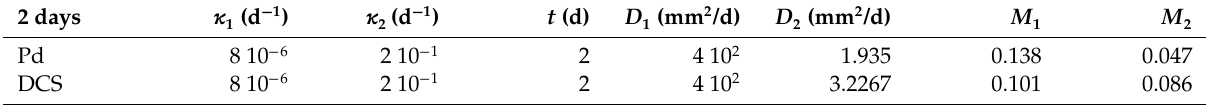
Table 5: Parameter values for chloride concentrations of pure concrete under PD after 2 days.